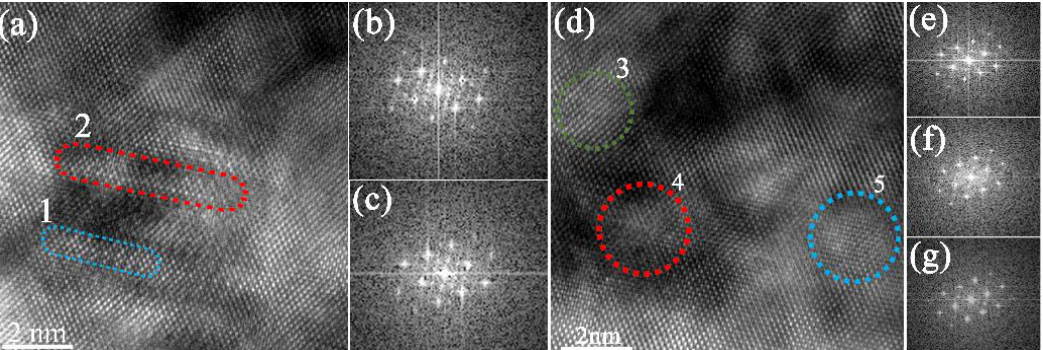
Figure 10. The high resolution TEM photographs of the refined Ni 2 Si precipitates in the Cu-Ni-Si alloy during the second step of aging at 450 °C for ( a ) 0.25 h, with ( b , c ) the corresponding SADP obtained by FFT transition of position 1 and 2, respectively, and ( d ) for 0.5 h with ( e – g ) the corresponding SADP obtained by FFT transition of position 3, 4 and 5, respectively.